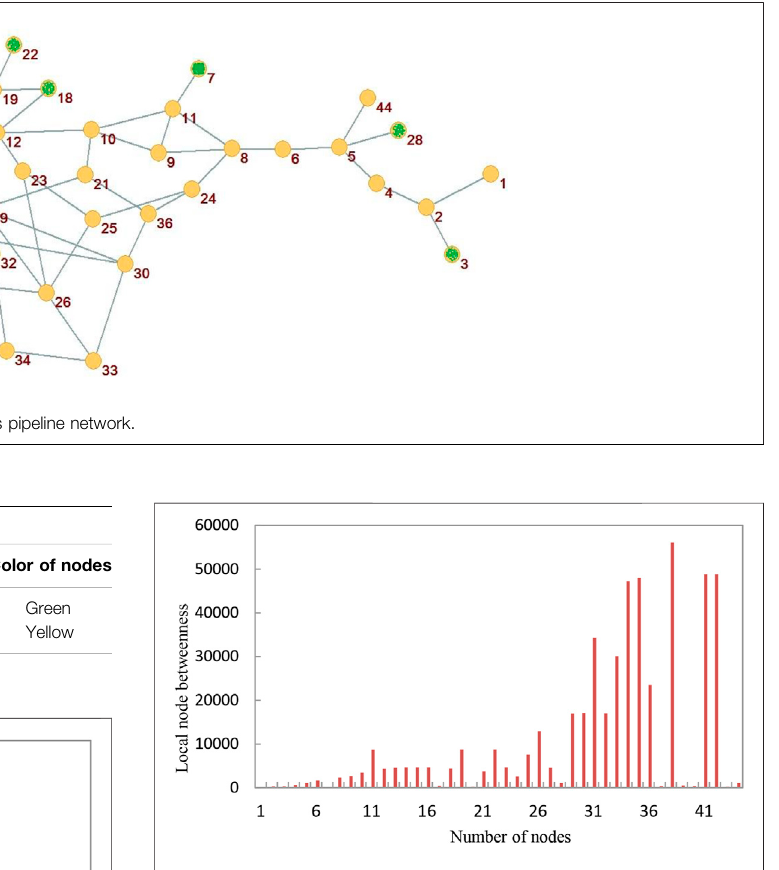
FIGURE 9 | The statistical diagram of each node ’ s local betweenness centrality value.